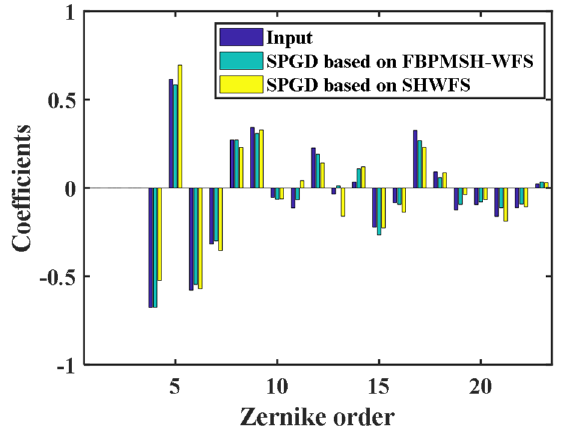
Figure 15. Recovered first 35 Zernike coefficients based on both structures.